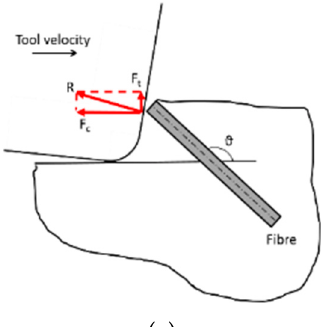
Figure 27. The trend of thrust force with respect to fibre orientation during cutting at a speed of 570 mm/min and rake angles of ( a ) − 10 ◦ , ( b ) 10 ◦ , ( c ) 30 ◦ .